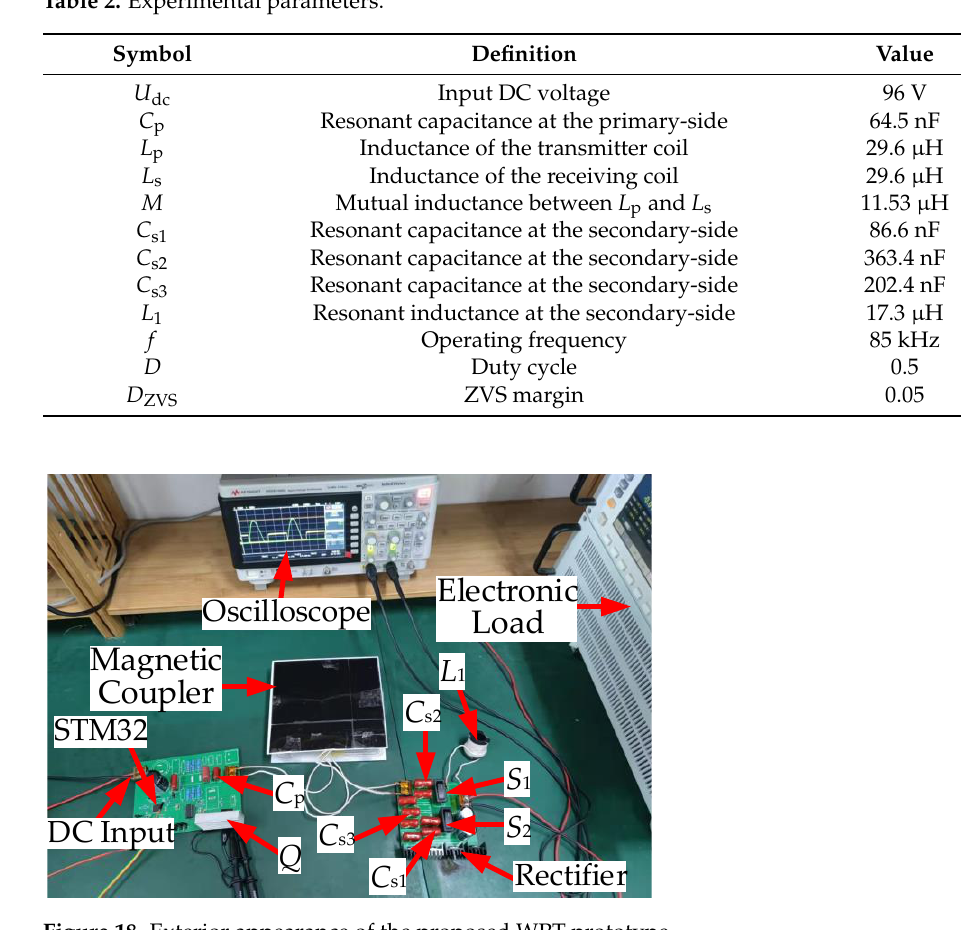
Figure 18. Exterior appearance of the proposed WPT prototype.